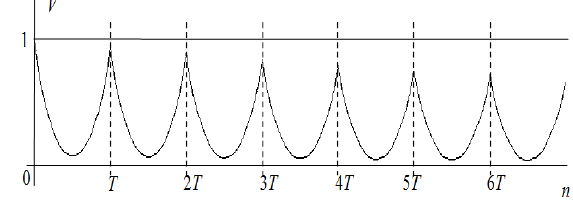
Figure 5. The graph of